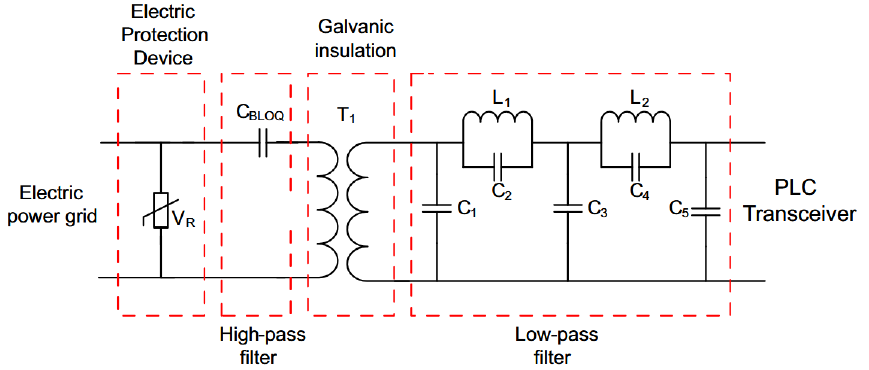
Figure 5. The block diagram of NB, capacitive, single-input single-output (SISO), and low-voltage PLC coupling